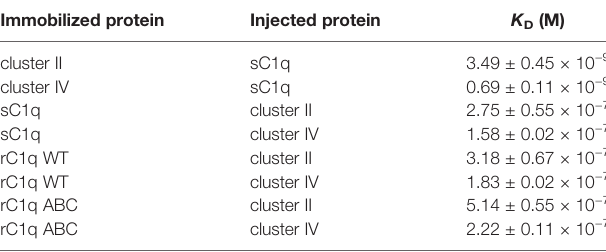
Values are expressed as means ± SE of two separate experiments.